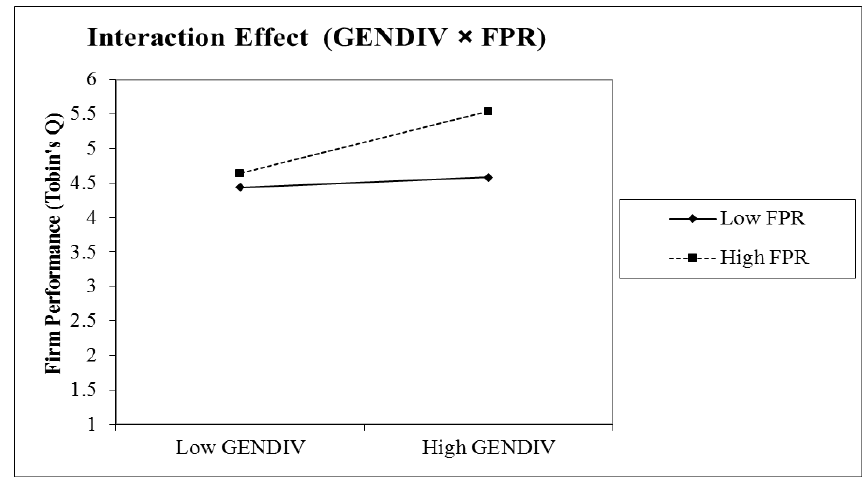
Figure 3. Interaction Effect (Gender Diversity × Ethnic Diversity).